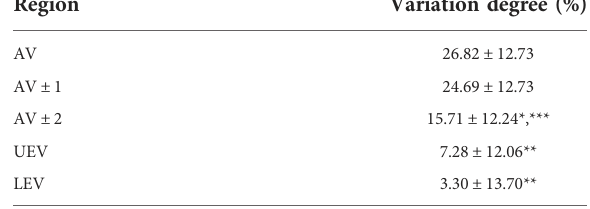
TABLE 3 Hu value in AIS patients. . Structural curve Non-structural curve